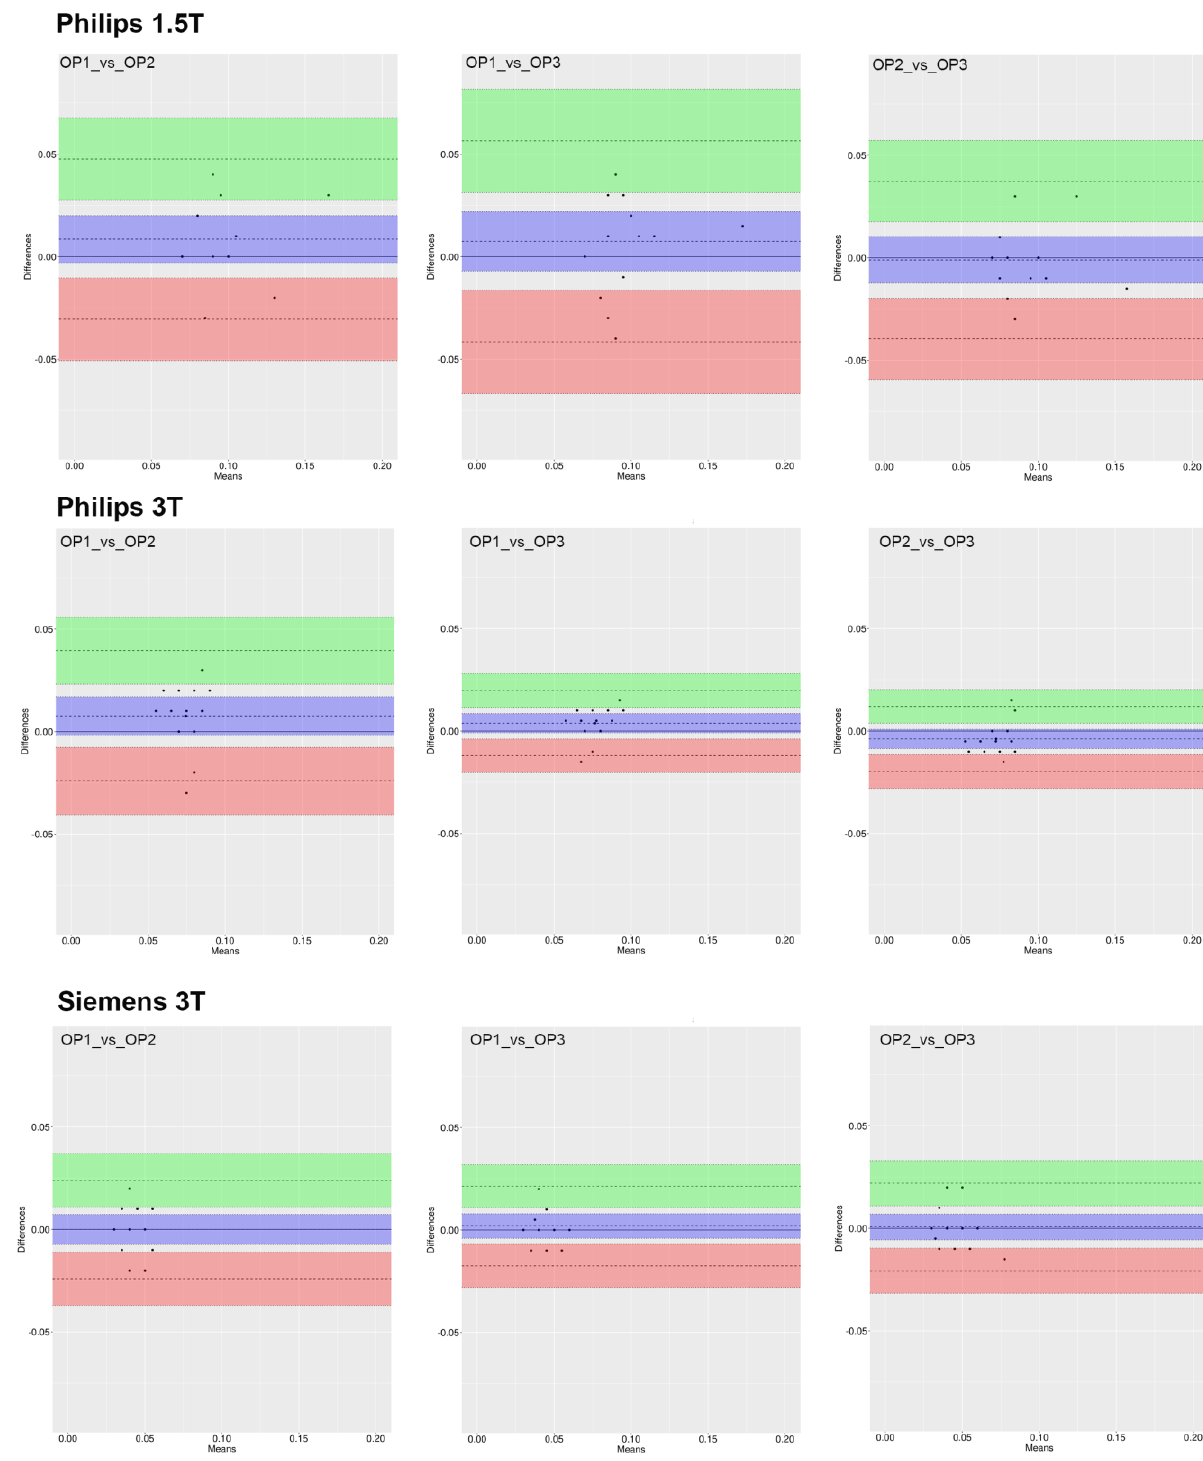
Figure 5. Bland–Altman plot of CircWSS measures for each pair of raters. The dashed line represents the mean difference along with the 95% CI (violet box). The lower (red box) and higher (green box) limits of agreement (LoA) defined as the mean difference ± 1.96 standard deviations of differences are reported along with the corresponding 95% CI.